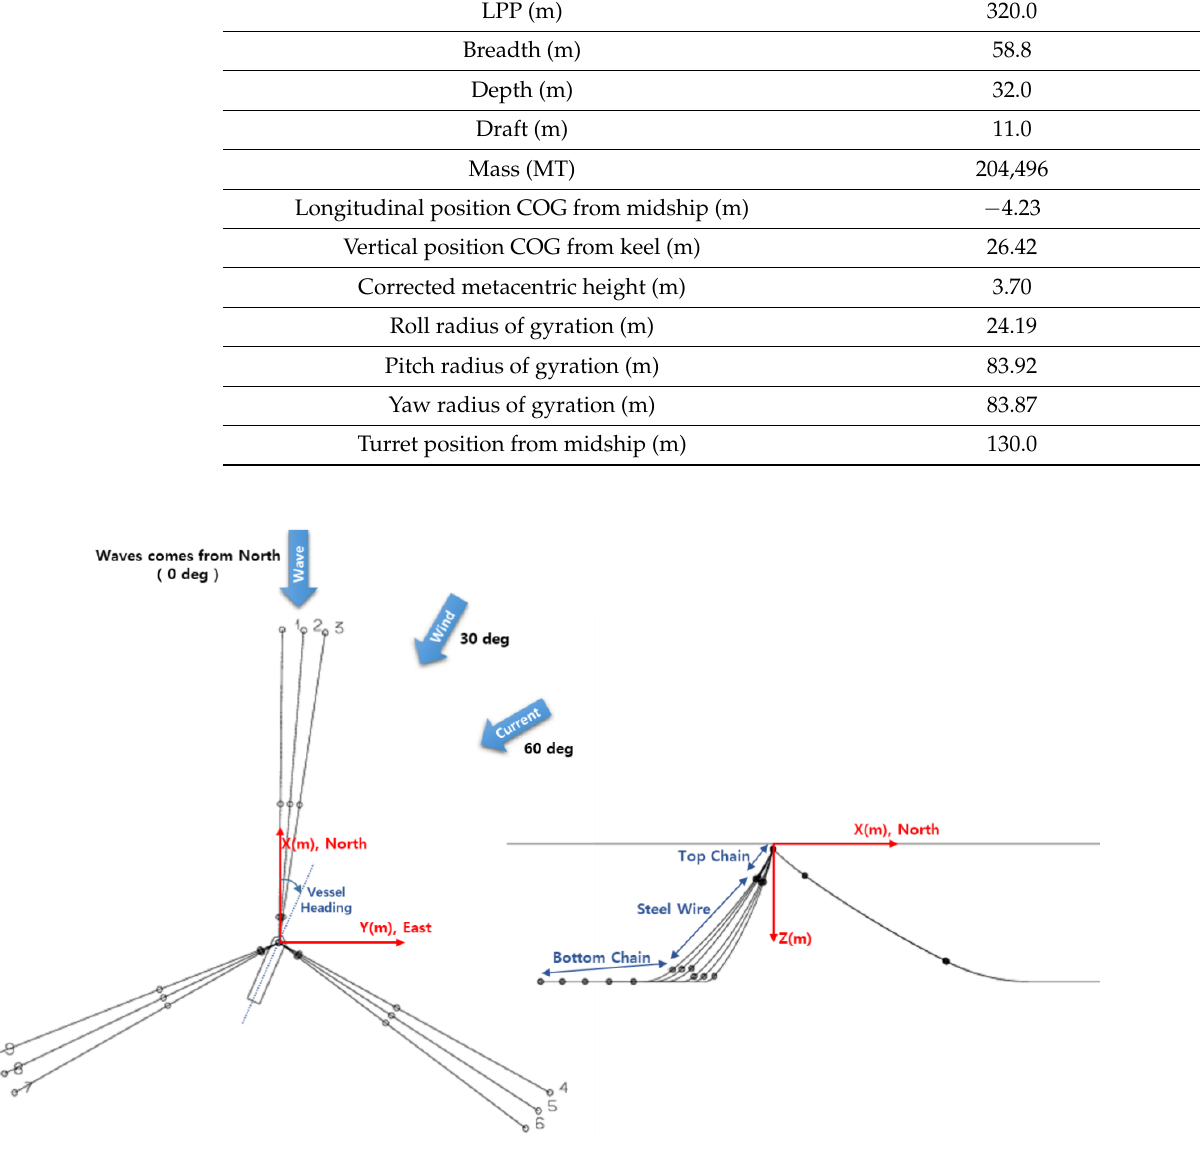
Figure 1. The coordinate convention and environmental condition direction. In the initial condition, the FPSO heading points North. The X -axis and Y -axis in the global coordinate system are directed East and North, respectively. As shown in Figure 1, the X - Y plane coincides with the free water surface, and the Z -axis points downwards. The motion of the FPSO is described relative to the global fixed coordinate system, with a positive rotation